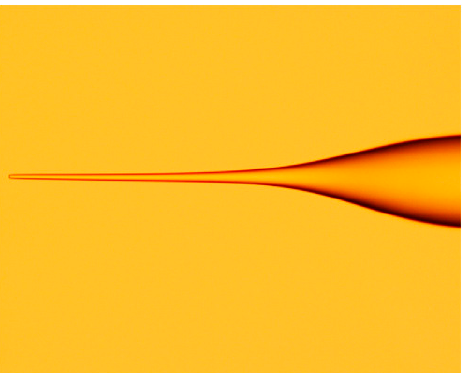
Figure 9. Microscope image of the fabricated tapered MMF tip [18]. Reproduced with permission